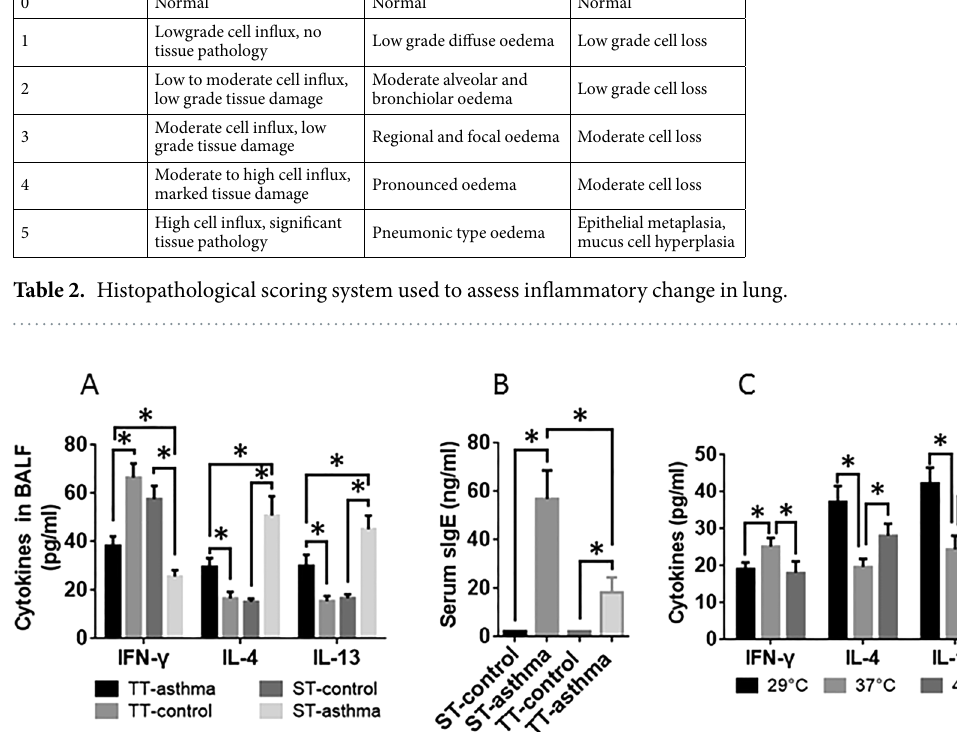
Figure 2. The effects of ambient temperature on IFN- γ , IL-4, IL-13 and serum OVA specific IgE. The BALF and sera were collected from the mice and analyzed by ELISA. The bars indicate the cytokine levels in the BALF ( A ) and the antigen-specific IgE in the serum ( B ). ST: standard temperature (20 °C); TT: thermoneutral temperature (30 °C). Control: Naïve mice. Asthma: Asthma mice. ( C ) Spleen cells were cultured at the indicated temperature for 48 h in the presence of ionomycin. The data are presented as mean ± SEM. * P < 0.01 (t test). Each group consists of 6